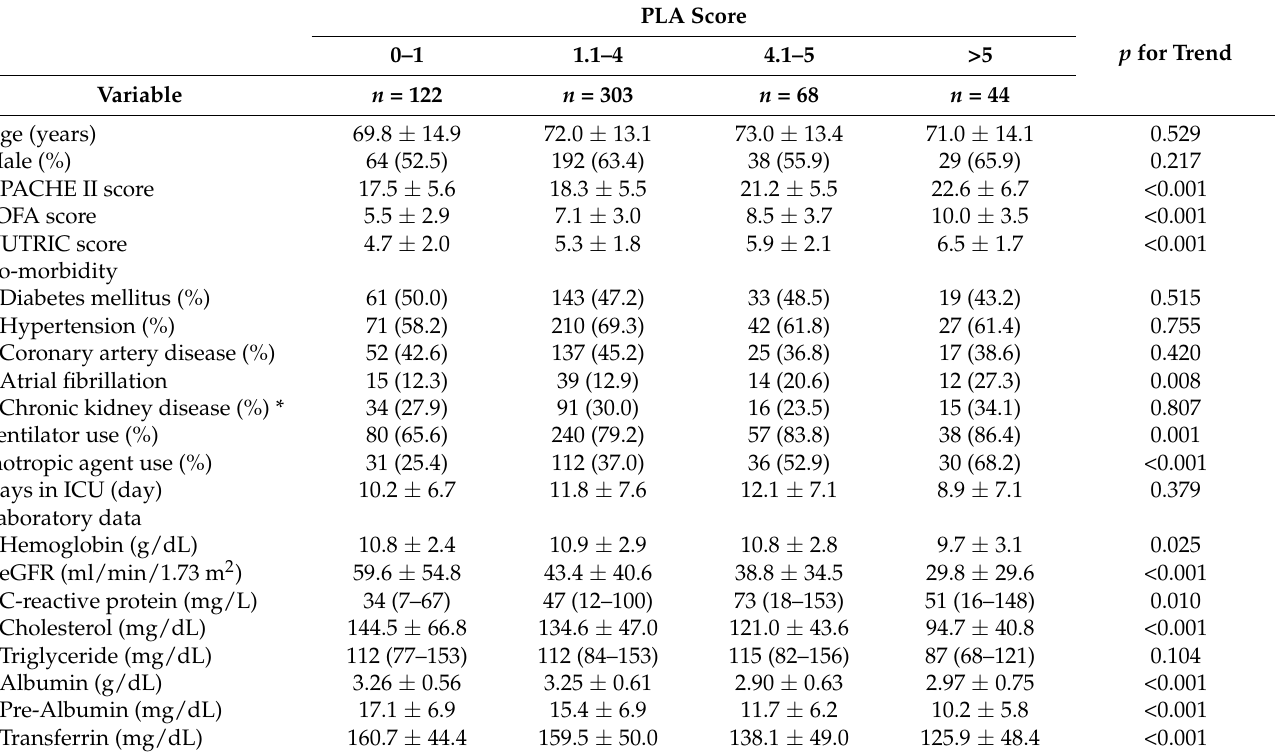
Table 3. Characteristics of patients with different PLA scores in the initiation